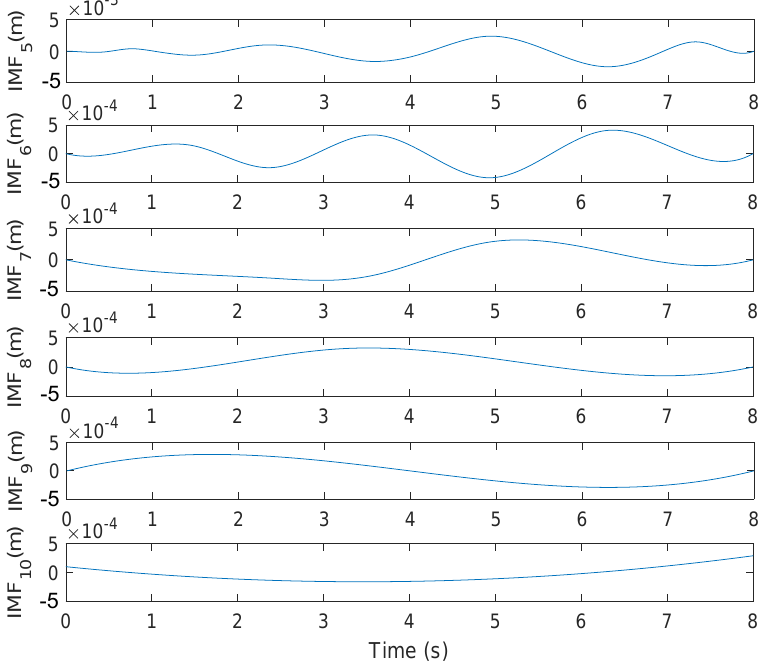
Figure 13. Low frequency class: IMF 5 to IMF 10 extracted from ξ y ( t ) . Hilbert spectral analysis of the modes has been performed. The IF f 1 ( t ) of the first mode ( IMF 1 (t)), is shown in Figure 14b. The frequency modulation is explicitly shown. Theses oscillations are attributed to the variation of the cavity length. Both variations ( f 1 ( t ) and L p ) have the same frequency. The component f 1 ( t ) oscillates from 39.38 Hz to 44.98 Hz except at the beginning of the